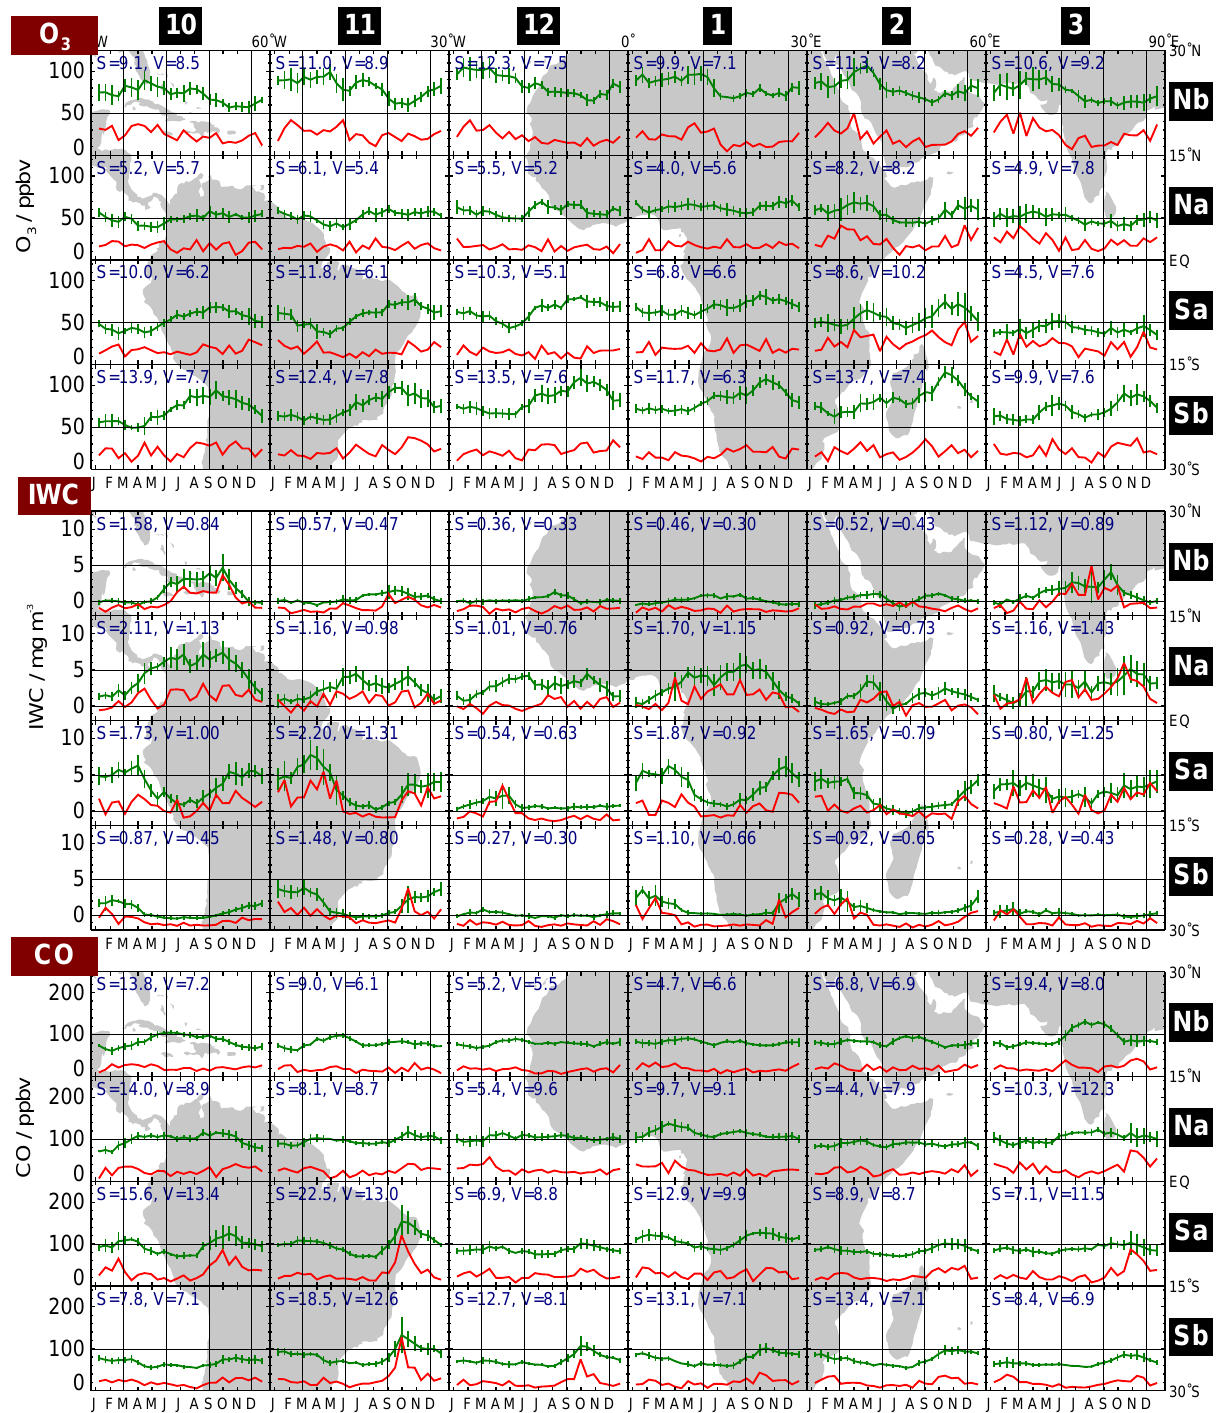
Fig. 3. Multi-year averages and variabilities of the MLS 215-hPa O 3 (upper), IWC (middle) and CO (lower) observations. The two weekly- averages in the earlier figures are themselves averaged and shown by the dark green line ( x ? in the text), with the corresponding interannual f standard deviation shown as the error bar. In order to better discern seasonal differences in interannual variability, this standard deviation is also shown by the red line (multiplied by 3 for clarity, with zero at the bottom of each panel, i.e., at 0ppbv for O 3 and CO, but − 2mgm − 3 for IWC). The S and V metrics discussed in the text are shown in each panel (in the same units as the